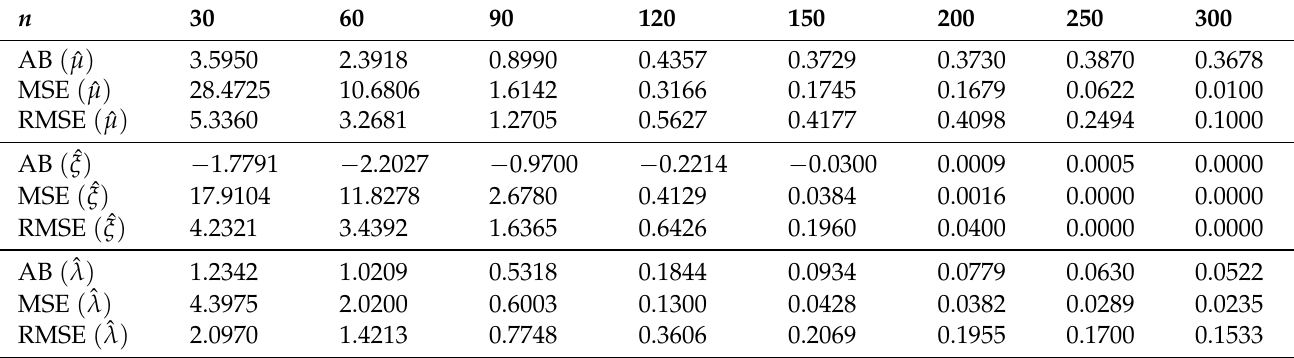
Table 3. Numerical outcomes of AB and MSE values of the NIGT-II model for µ = 1.9, ξ = 3.3, λ =